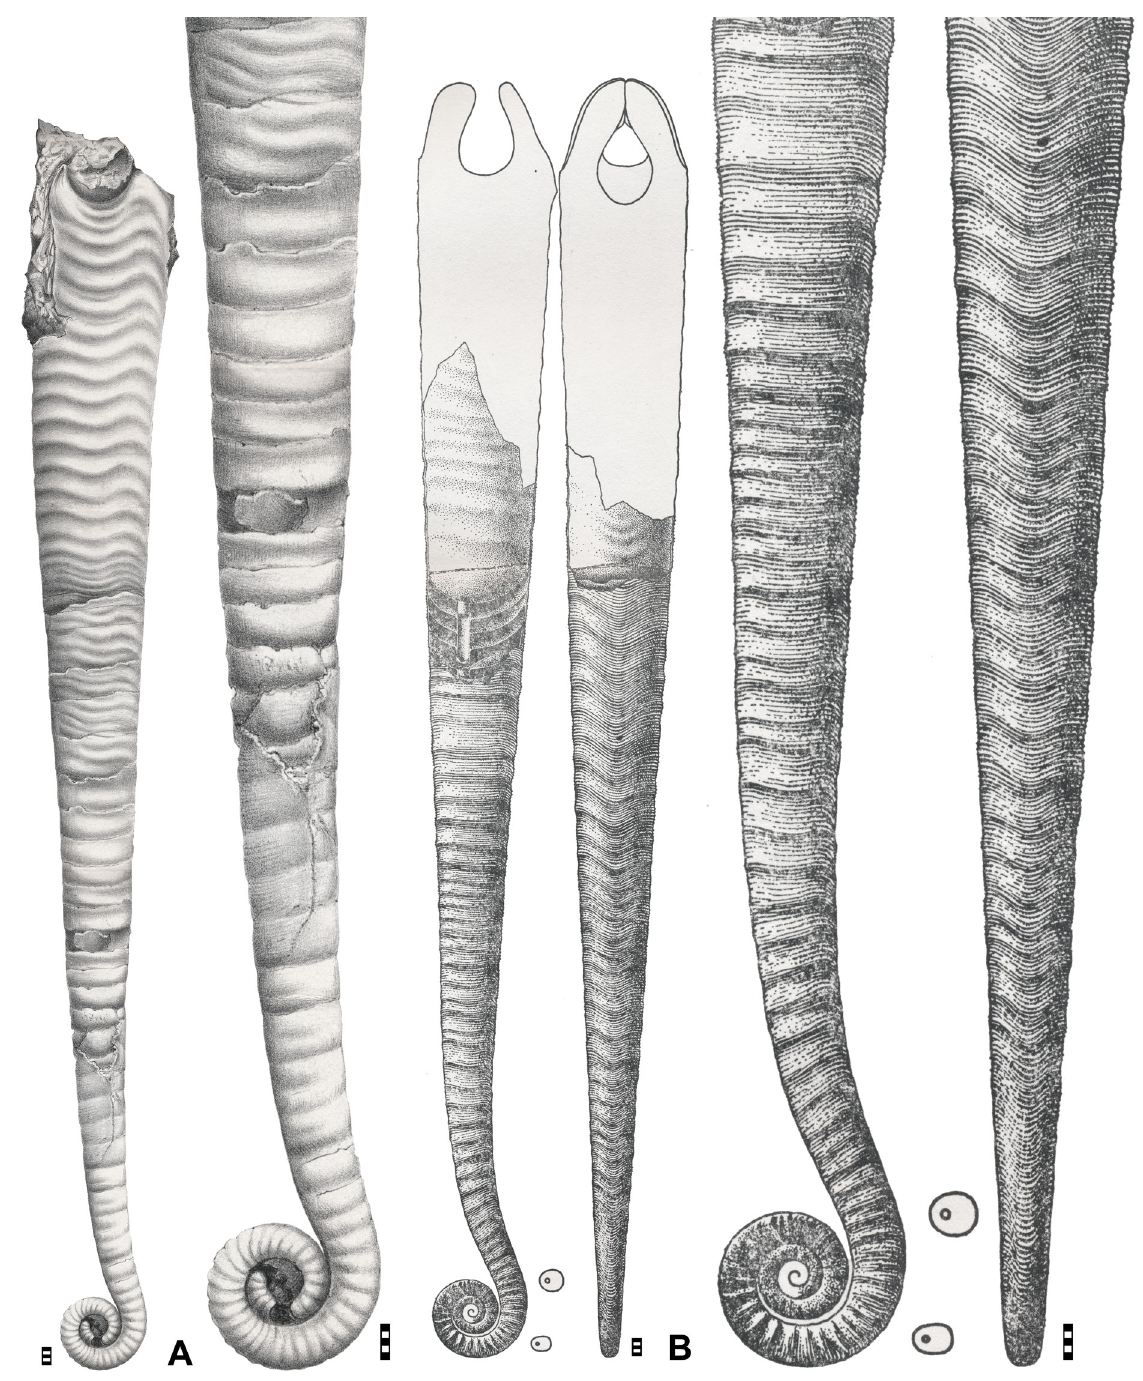
Fig. 31. Lituites lituus de Montfort, 1808; reproductions from the literature. A . Reproduction of the illustration by Noetling (1882: pl. 11 fig. 1). B . Reproduction of the illustration by Dzik (1984: pl. 41 fig. 1). Scale bar units = 1